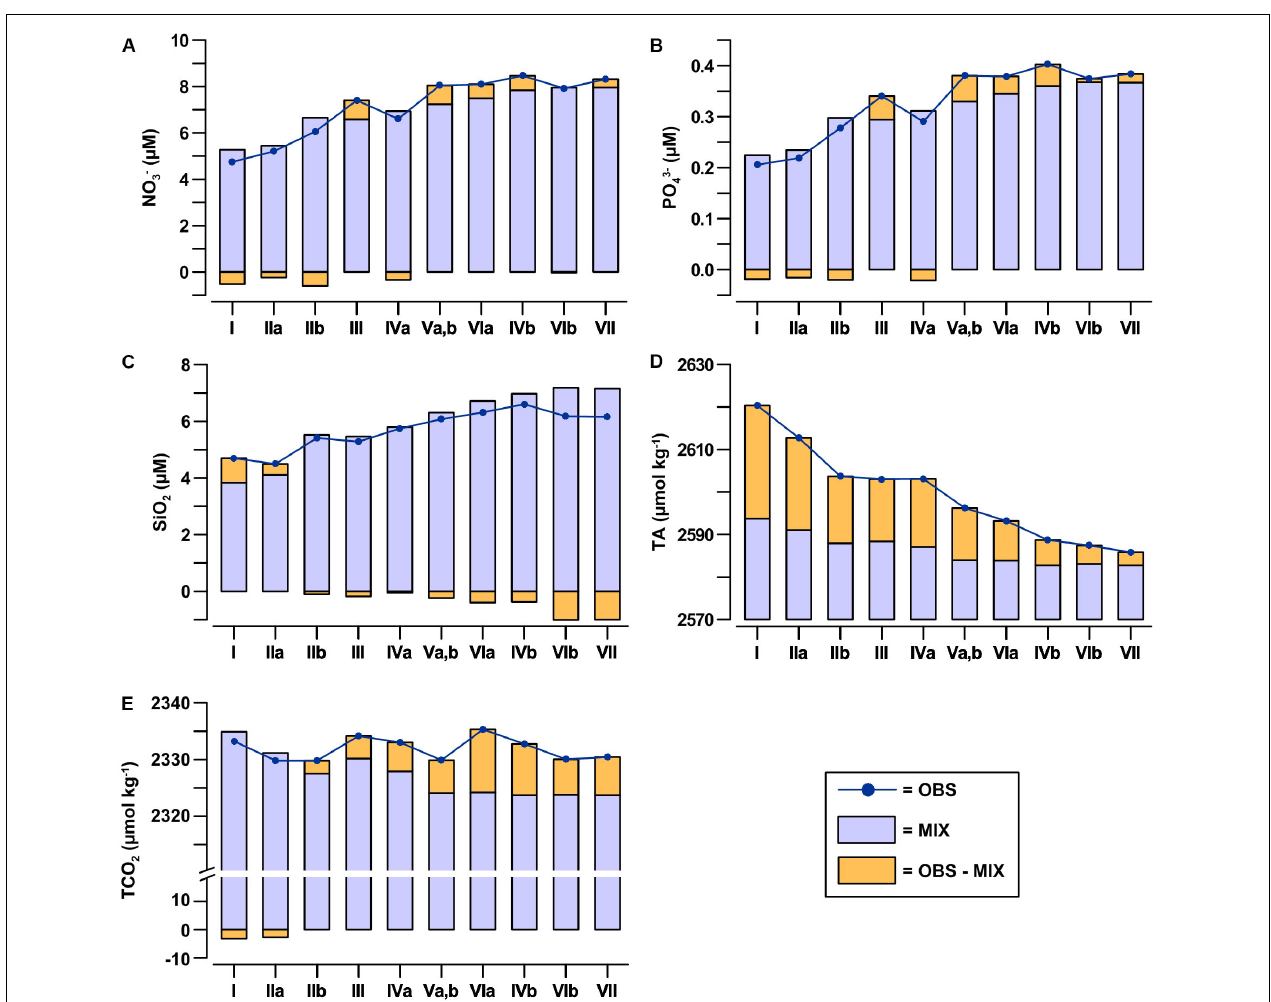
FIGURE 7 | Results of the OMP analysis on major nutrients [ (A) nitrate, (B) phosphate, (C) slicate] and in situ inorganic carbon [ (D) TA, (E) TCO 2 ] with respect to the subregion I: observed concentrations in the IW core (OBS), theoretical concentrations derived by OMP (MIX) and differences between observed and theoretical concentrations (OBS–MIX). For the calculation, AW and DW end member concentrations were determined using median values of the layers 100–150 m and 600–1000 m,